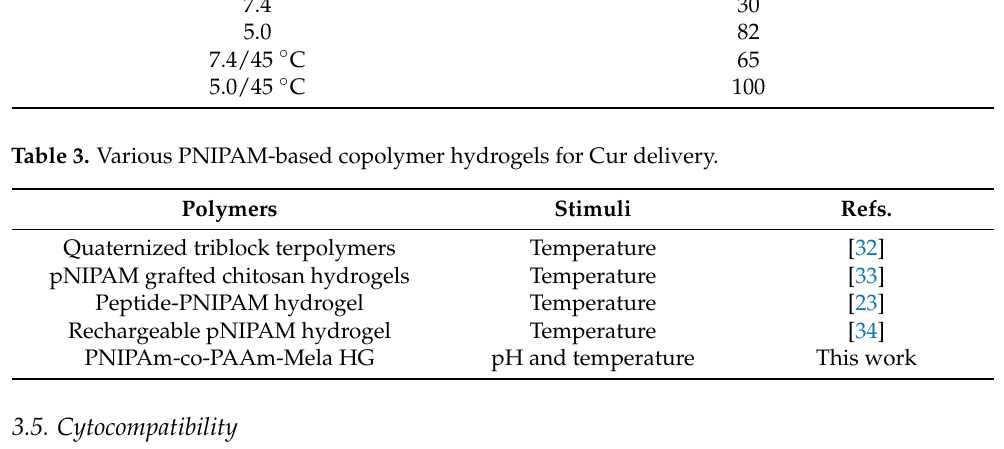
Table 2. Cur release efficiency from PNIPAm-co-PAAm-Mel HG system at pH/temperatures. Table 1. Cur release efficiency from PNIPAm-co-PAAm-Mela HG system at different tempera- tures.